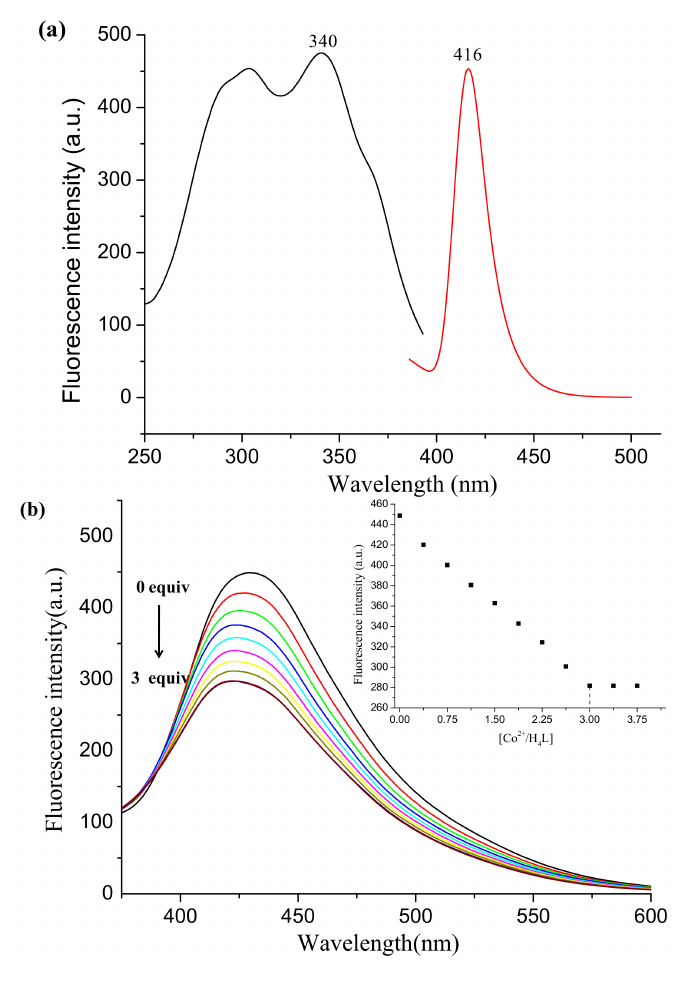
Figure 9. ( a ) The excitation and emission spectra of the Co(II) complex. ( b ) fluorescence emission spectrum changes of H 4 L in methanol solution by the addition of Co(II) ions.